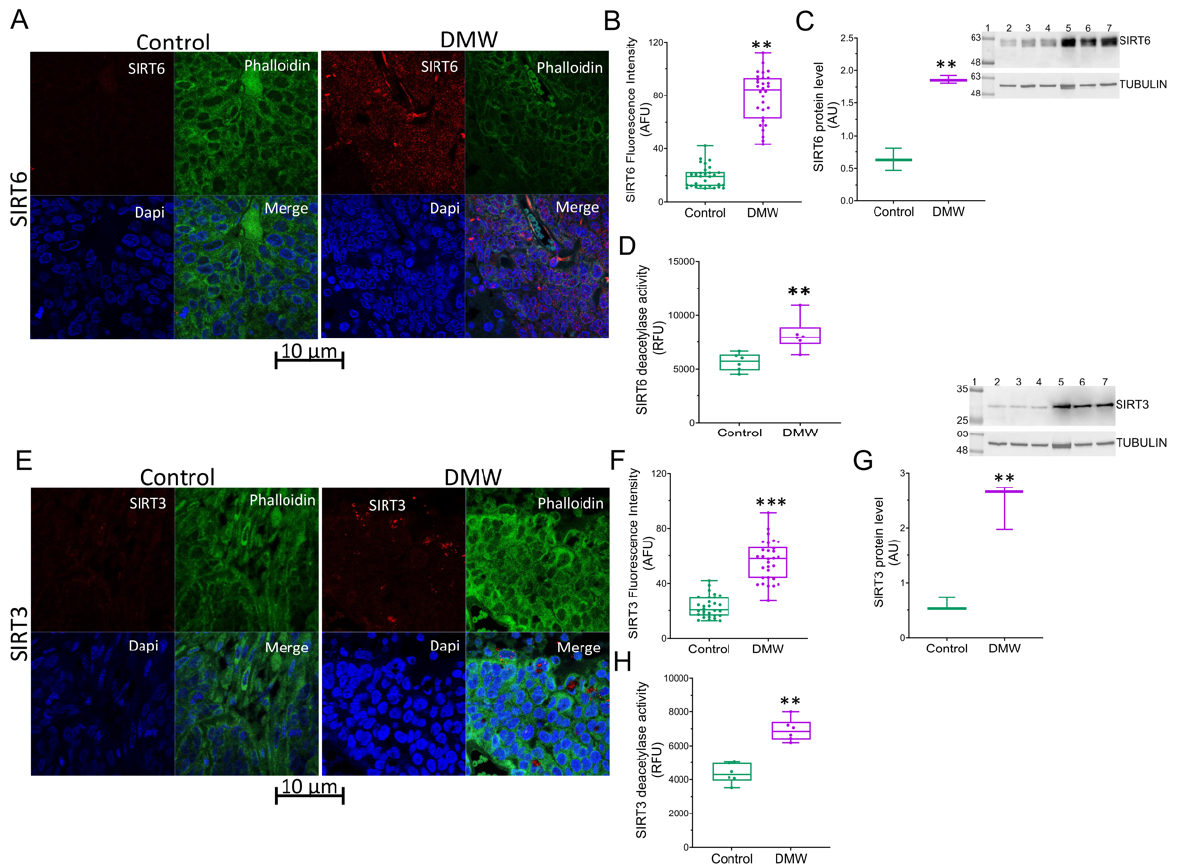
Figure 5. DMW modulates SIRT6 and SIRT3 expression and activity in xenograft model of colorectal cancer. Representative immunofluorescence images and analysis, protein expression levels and deacetylase enzymatic activity of ( A – D ) SIRT6 and ( E – H ) SIRT3 in control and DMW-treated mice. Fluorescence intensity determination, reported as boxplots representing the densitometric mean values of arbitrary fluorescence units (AFU). For immunoblotting study, boxplots represent the densitometric mean values, expressed as arbitrary units (AU) of n = 5 different experiments. Protein expression was determined after normalisation with α -tubulin as internal control with ImageJ software. Lane 1 = molecular marker; Lanes 2, 3, and 4 = control mice; Lanes 5, 6, and 7 = DMW-treated mice. ** p < 0.01 and *** p < 0.001 vs. control mice.